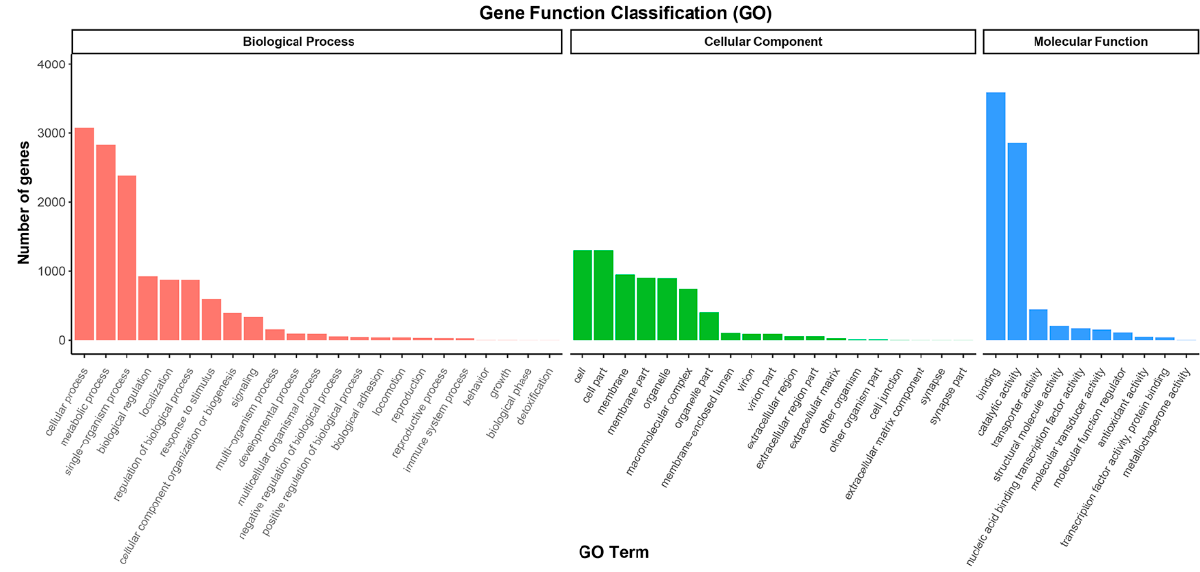
Figure 2. Gene Ontology functional classification of all the unigenes of Heterosigma akashiwo . For the KEGG classification, 6551 (39.30%) unigenes were annotated to different functional groups, including cellular processes, organismal systems, and metabolism. Among them, the unigenes that are involved in metabolism account for 29.57%. In addition, there were 416 unigenes associated with energy metabolism (Figure 3).